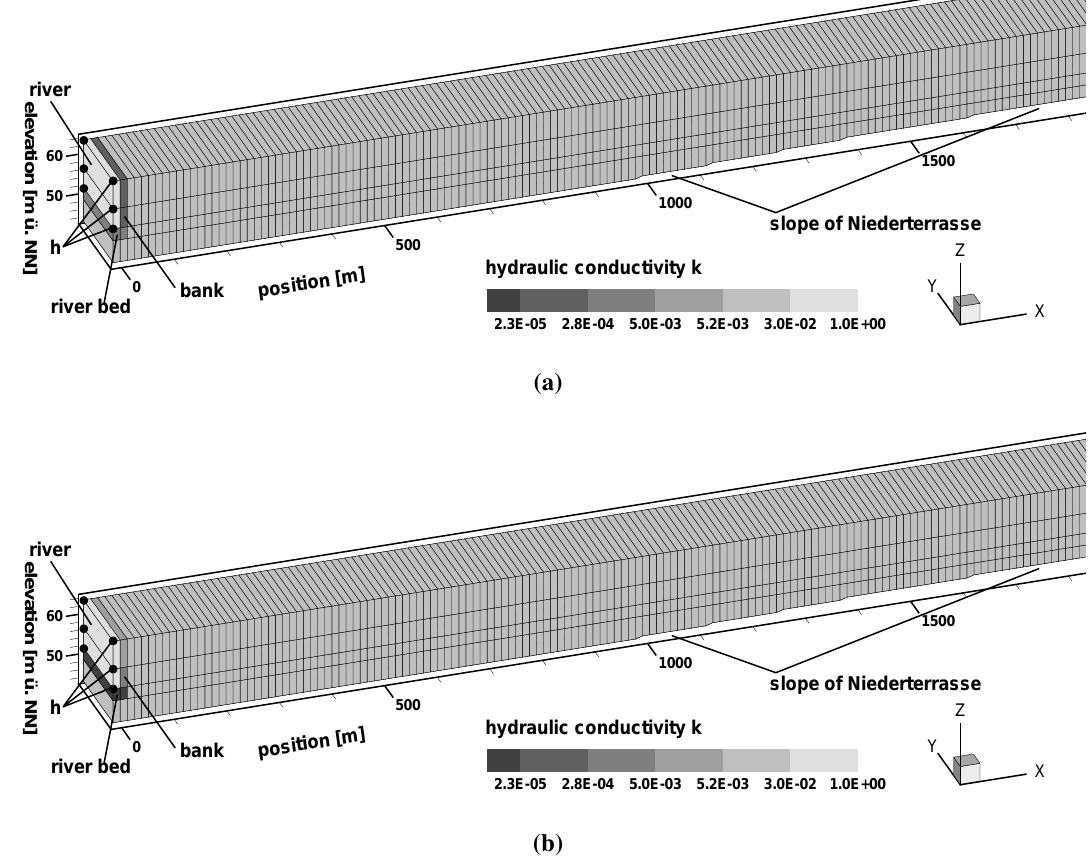
Figure 9. Finite element discretisation of the groundwater model representing the vertical cross-section of the aquifer along the chain of observation points near Urmitz. The pictures show the model variant where the river water interchange is modeled with a head boundary condition. The coloring of the finite elements indicate values of hydraulic conductivity after automatic and manual calibration, respectively (see Section 4.5 and Table 3). ( a ) Parameter distribution results of the manual calibration; ( b ) parameter distribution results of the automatic